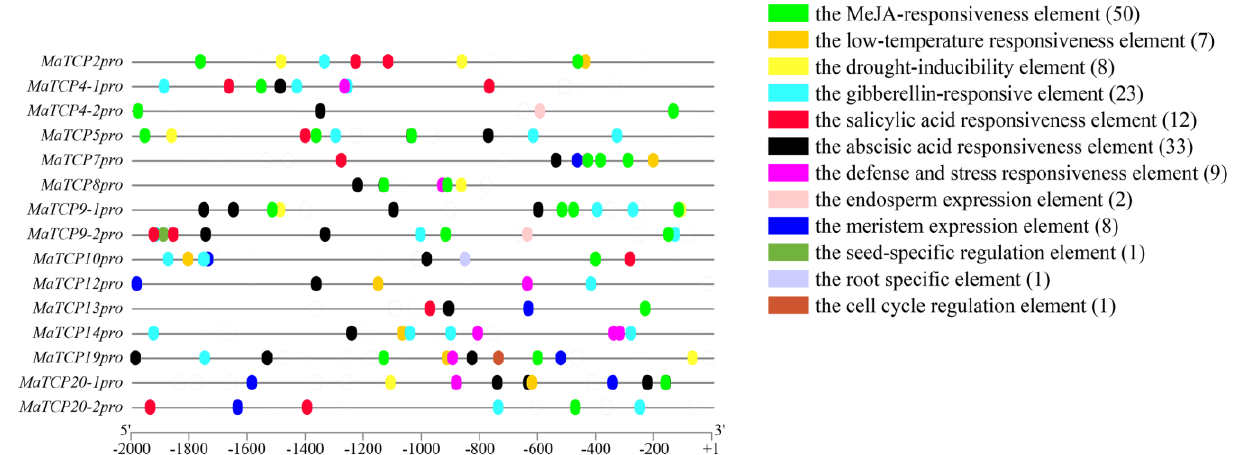
Figure 2. The promoter analyses of MaTCP genes. The number in parentheses indicated the number of cis- acting elements.